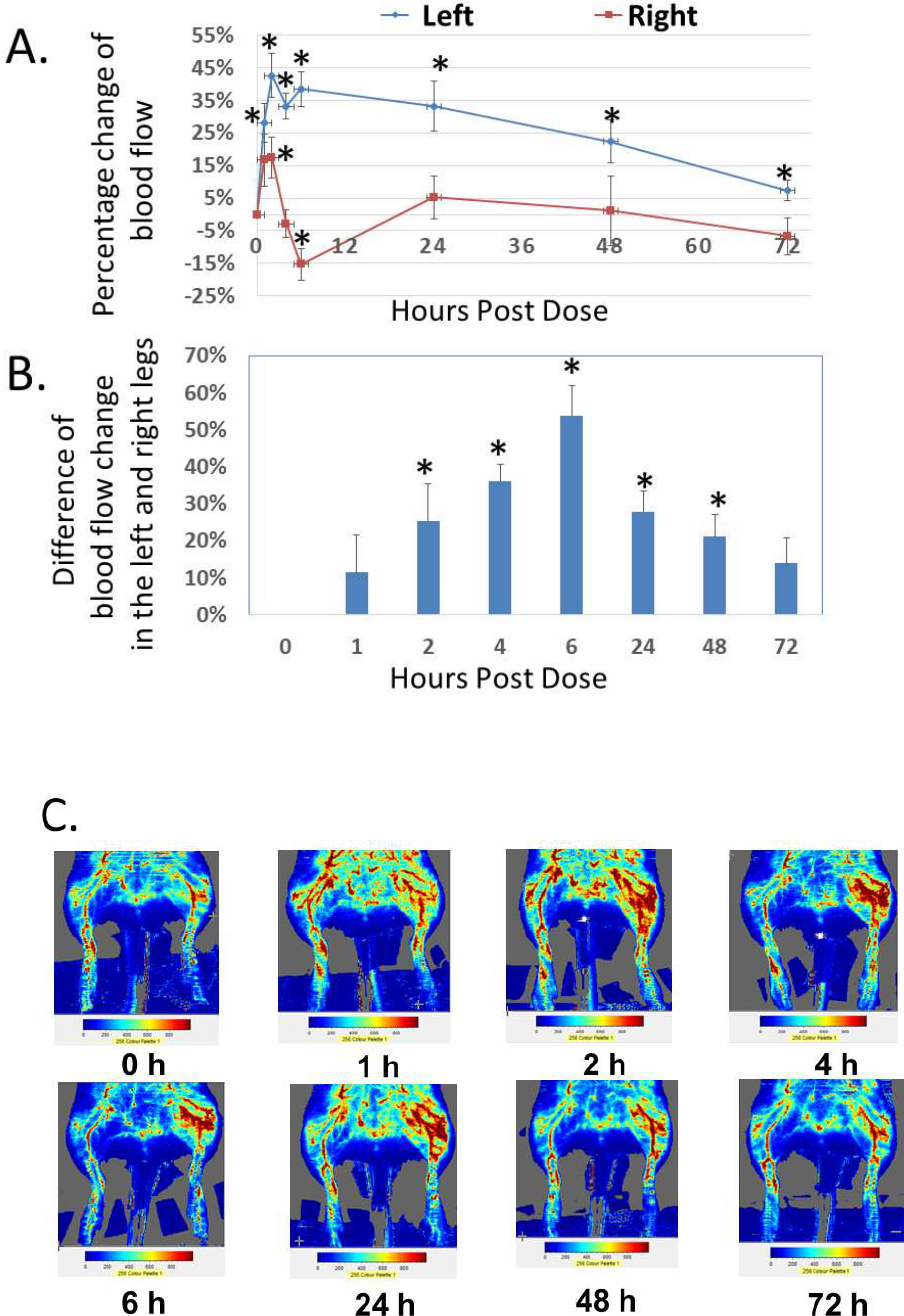
Figure 8. Analog C-6 gel solution has a prolonged effect on dermal blood flow in the hindlimbs of Sprague–Dawley rats. ( A ) Percentage changes of dermal blood flow in the left and right hindlimbs at 0, 1, 2, 4, 6, 24, 48, and 72 h after a subcutaneous injection of gel solution (8 mg in 8% solution) in the left hindlimb of anesthetized adult male Sprague–Dawley rats. The rats received the injection after the basal scans with a Doppler imager at the beginning of the experiment. The blood flow in the hindlimbs was again scanned at 1, 2, 4, 6, 24, 48, and 72 h after the start of the experiment. Data are reported as percent change from the average of baseline scans and are mean ± SEM of six separate animals. *, Significantly different from the basal level at 0 h. ( B ) The difference of changes in blood flow between the left (treatment side) and right (control side) hindlimbs at 0, 1, 2, 4, 6, 24, 48, and 72 h after the injection of gel solution at the left hindlimb. *, significantly different between the two hindlimbs. ( C ) Representative scans of dermal blood flow at different time points in animals that received an Analog C-6 gel solution